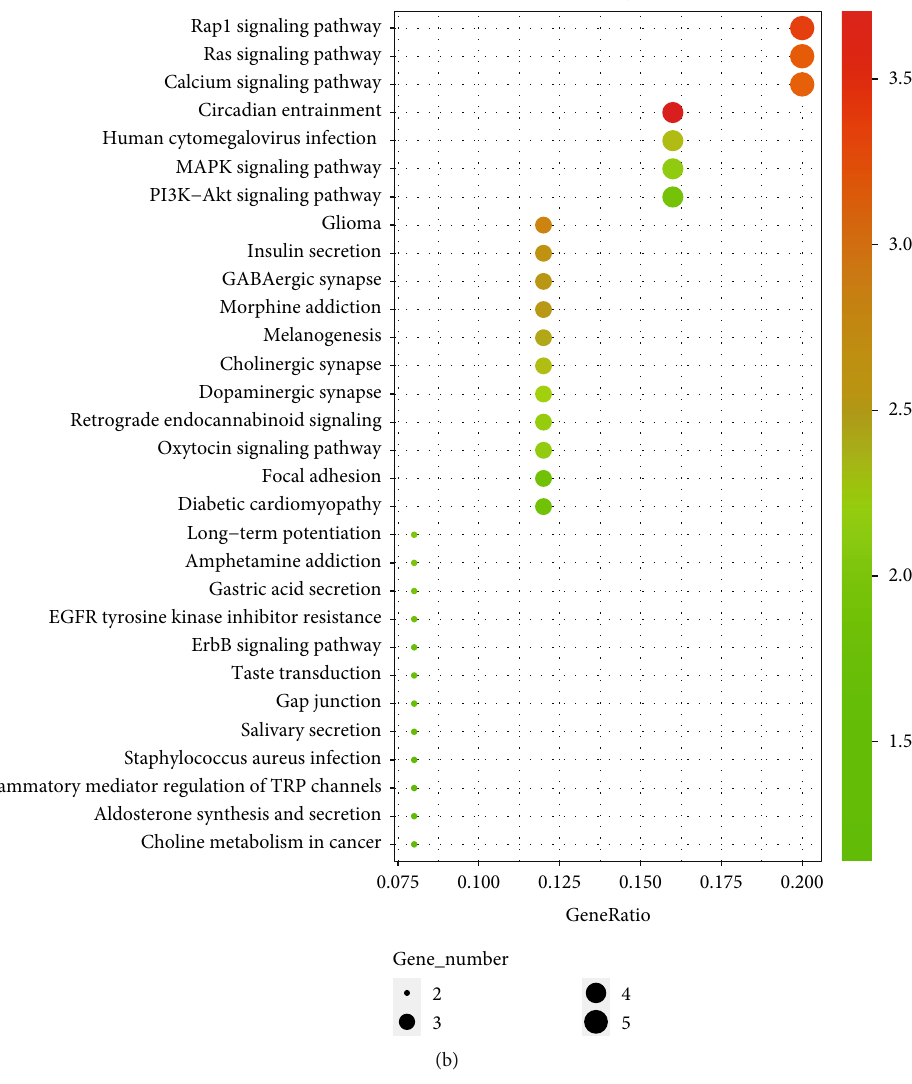
Figure 6: mRNA DEGs enrichment analysis. (a) GO enrichment analysis and (b) KEGG enrichment